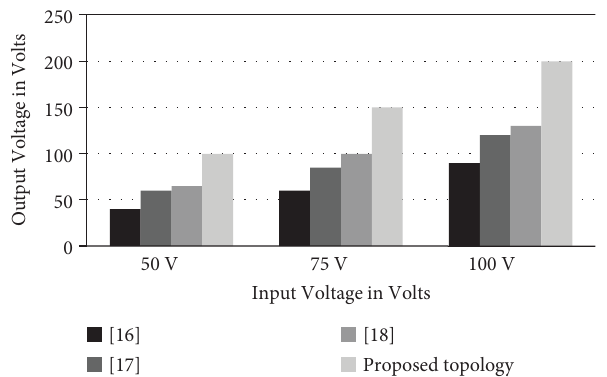
Figure 18: Comparison of output voltages of various